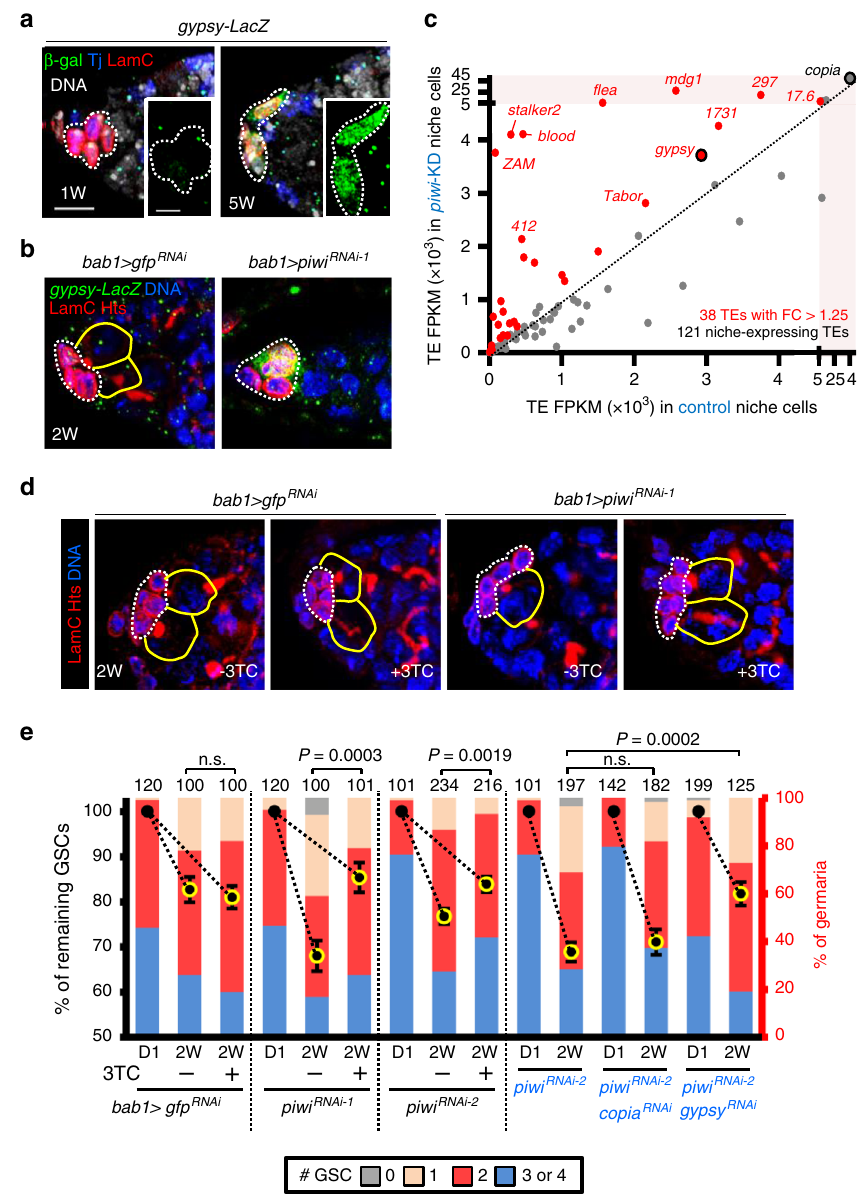
Fig. 2 Piwi suppresses retrotransposons for GSC maintenance. a gypsy-lacZ expression was increased in CpCs of 5-week (W)-old females (green, LacZ retrotransposon reporter; blue, Tj for CpC and EC nuclei; red, LamC for CpC nuclear envelopes; gray, DAPI for DNA). Scale bar, 5 μ m. Scale bar in inset image, 2.5 μ m. b gypsy-lacZ expression is increased in CpCs of the 2-week-old bab1 > piwi RNAi-1 germarium (green, LacZ retrotransposon reporter; blue, Tj; red, LamC; red, Hts for fusomes). Dashed circles, CpCs; yellow circles, GSCs. c Retrotransposon expression pro fi les in sorted control and piwi -KD niche cells. d Two-week - old bab1 > gfp RNAi-1 and bab1 > piwi RNAi-1 germaria with or without 3TC treatment (10 mM) (Red, LamC and Hts; blue, DAPI). e GSC numbers in 2-week-old germaria of indicated genotypes with or without 3TC treatment. Percentage (%) of remaining GSCs at 2W (left y -axis) represents GSC number at 2W with or without 3TC treatment normalized to GSC number of the same genotype at D1 (newly eclosed) shown in Fig. 1d. Note that GSC number of piwi RNAi-2 alone at D1 in 7th and 10th columns is the same data shown in Fig. 1d. % of germaria (Right y -axis) indicates the proportion of 2-week- old germaria carrying 0, 1, 2, 3, or 4 GSCs. Error bars of left- y -axis in e , S.E.M. n.s., non-signi fi cant. Yellow outline on symbols indicates that the % of remaining GSCs is signi fi cantly lower than D0 of the same genotype. Student ’ s t -test was used for comparisons of % remaining GSCs. All images ( a , b , and d ) are the same magni fi cation and share scale bar with a . All inset images ( a ) are the same magni fi cation. At least two biological replicates were performed for each